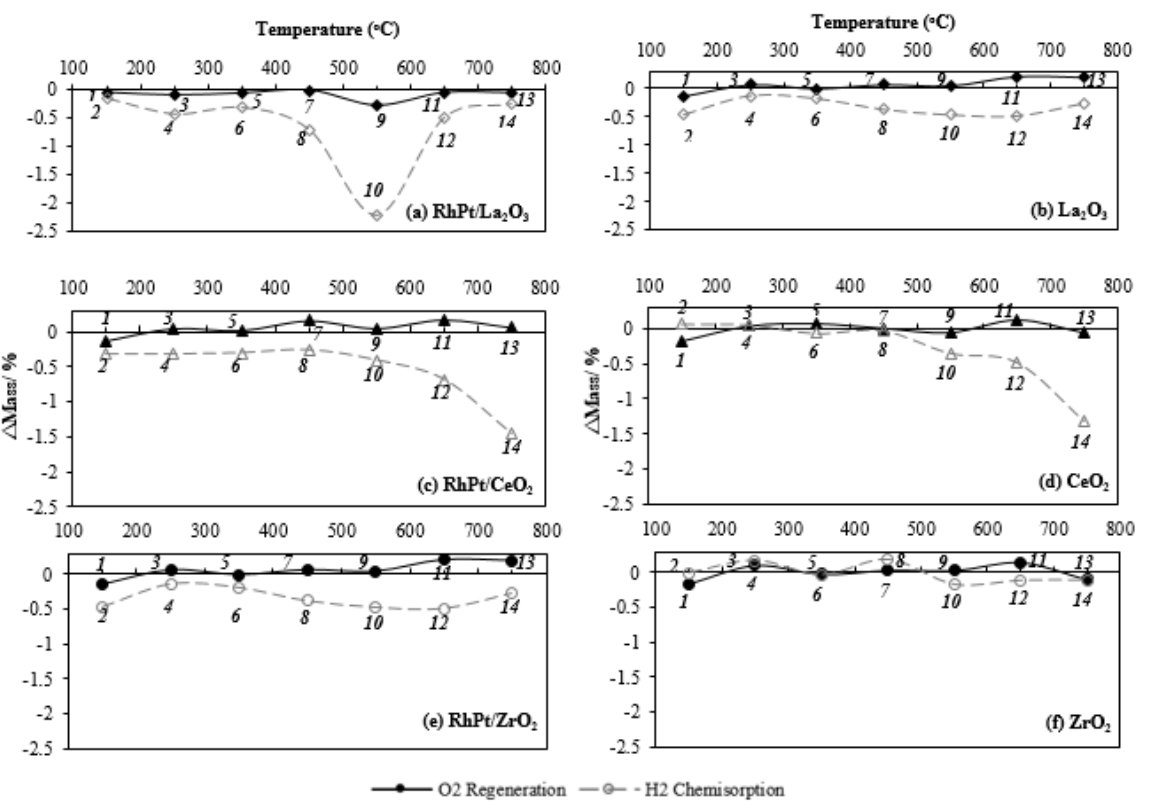
Figure 3. Oxidation in 1%O 2 /N 2 (No. 1, 3, 5, 7, 9, 11, 13) and reduction in 4%H 2 /N 2 (No. 2, 4, 6, 8, 10, 12, 14) as a function of temperature in a thermogravimetric analysis